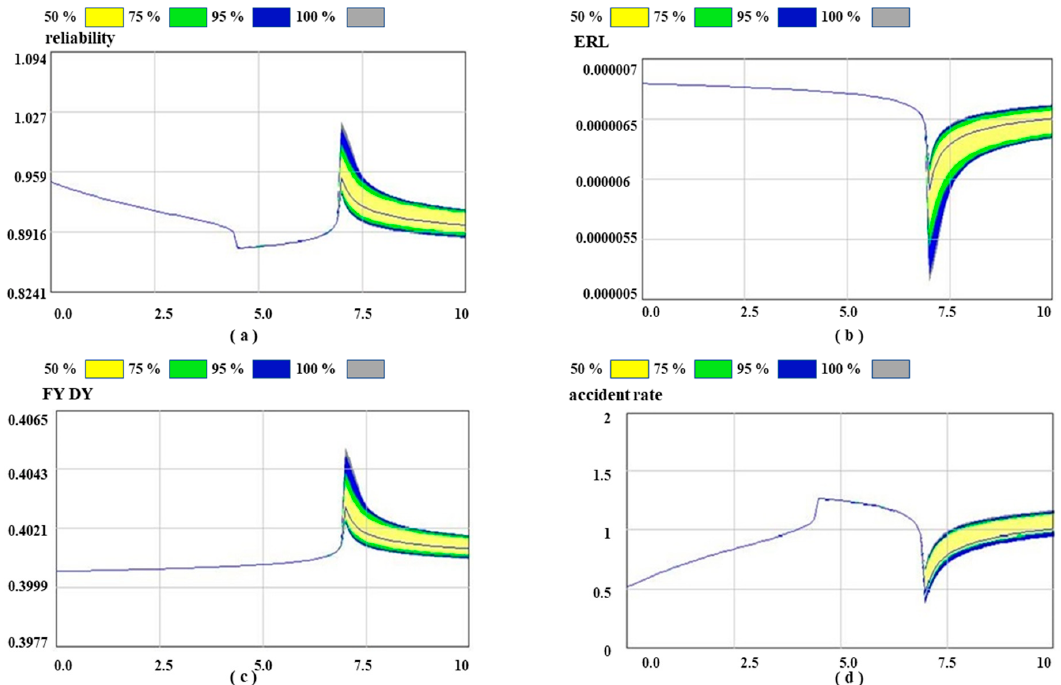
Figure 6. Sensitivity analysis: ERL and Reliability- TD01, Case #1. Note: SD Individual ERL sensitivity plots for all other Trial Designs for Case #1 to #7 are provided in Supplementary Material— Figures S11–S24. ( a ): reliability; ( b ): ERL; ( c ): FYDY; ( d ): accident